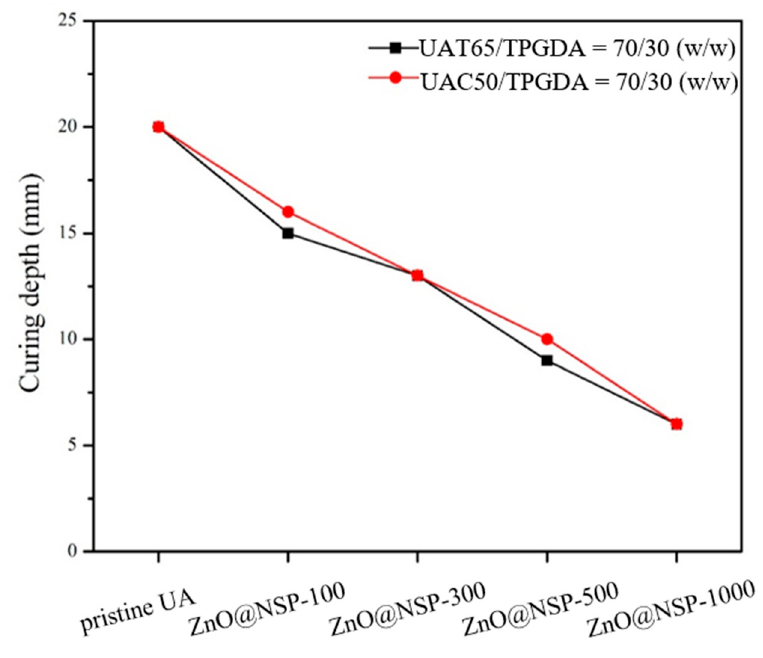
Figure 10. Curing depths of UAT65/TPGDA resins ( w/w = 70/30) and UAC50/TPGDA resins ( w/w = 70/30) with various ZnO@NSP contents (ppm).